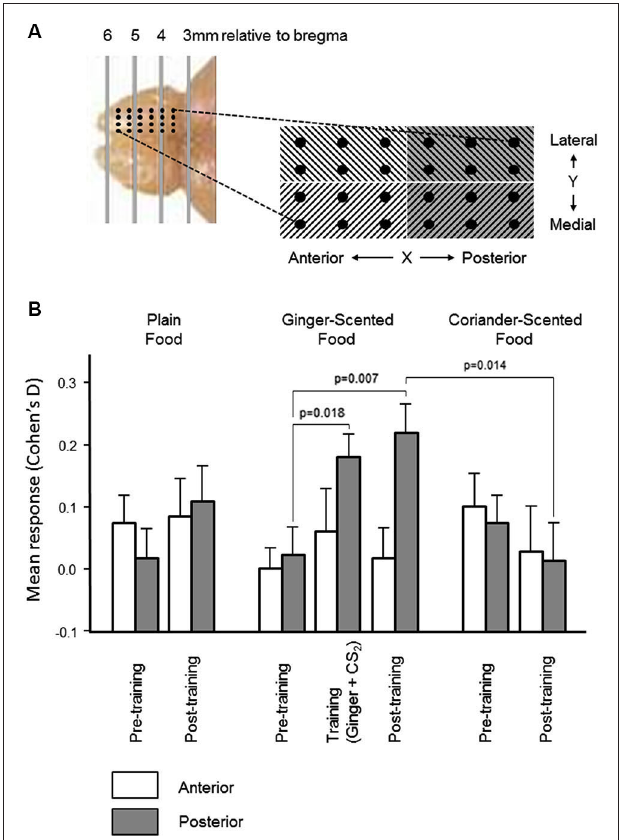
FIGURE 4 | Spatial distribution of olfactory bulb neural responses during learning. (A) In order to establish the spatial distribution of olfactory bulb mitral cell responses and learning-related changes, the microelectrode array was partitioned mediolaterally and anteroposteriorly (photograph and schematic illustrate the localization of the 24-electrode arrays). There was no significant variation in multiunit responses, or in learning-related changes, across the mediolateral dimension of the array. Histograms in (B) show that the increase (mean ± sem) in the size of the multiunit responses to the combined presentation of ginger and CS 2 , and the learning-related increase in the size of the multineuron response to ginger was restricted to the posterior half of the